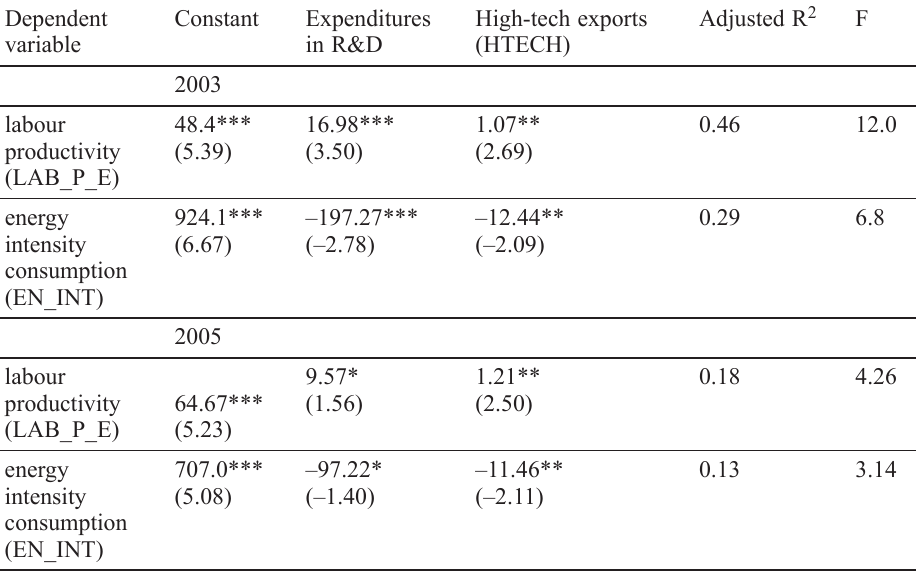
Table 8. Regression analyses of labour productivity and energy intensity consumption in the selected 33 European economies in 2003 and